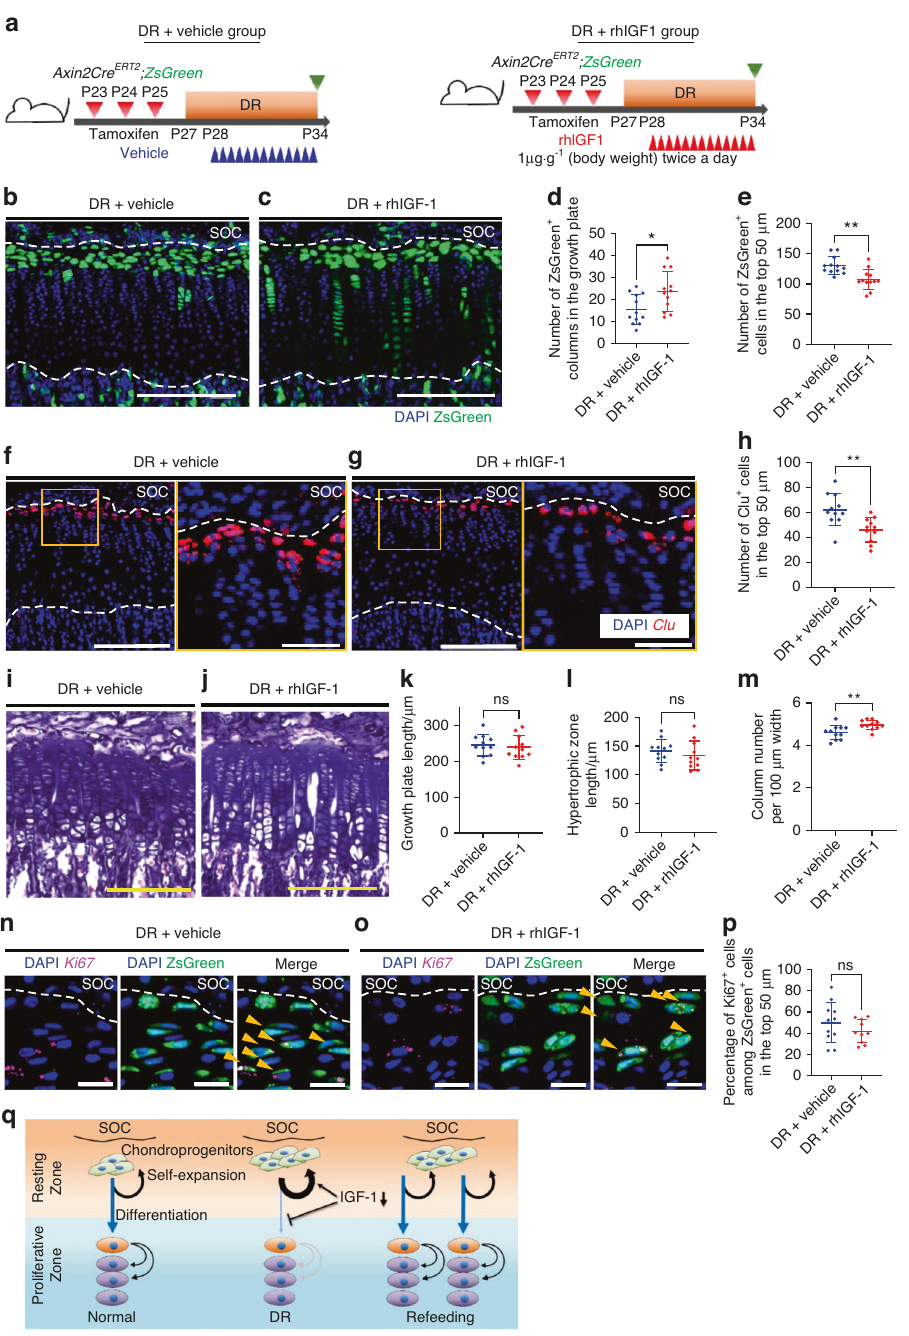
Fig. 7 Exogenous IGF-1 promotes committed differentiation of resting chondrocytes under dietary restriction. a Schematic diagrams of the fate-mapping analysis of Axin2 + cells in the proximal tibial growth plate in Axin2Cre ERT2 ;R26R ZsGreen mice (pulsed on P23 – 25 and traced for 11 days). b Representative images of descendants of initially labeled Axin2 + cells (ZsGreen + cells) in the proximal tibial growth plate in the DR + vehicle ( b ) and DR + rhIGF-1 ( c ) groups. d , e Quanti fi cation of the ZsGreen + columns in the growth plate ( d ) and ZsGreen + cells in the top 50 µm ( e ). DR + vehicle group ( n = 12), DR + rhIGF-1 group ( n = 12). f , g Representative images of in situ hybridization of Clu in the proximal tibial growth plate in the DR + vehicle ( f ) and DR + rhIGF-1 ( g ) groups. h Quanti fi cation of Clu + cells in the top 50 μ m. DR + vehicle group ( n = 11), DR + rhIGF-1 group ( n = 11). i , j Representative images of hematoxylin and eosin staining in the proximal tibial growth plate in the DR + vehicle ( i ) and DR + rhIGF-1 ( j ) groups. k – m Quanti fi cation of growth plate length ( k ), hypertrophic zone length ( l ) and column number per 100 µm width ( m ). P = 0.666 9 (ns) ( k ), P = 0.426 4 (ns) ( l ), ** P = 0.008 4 ( m ). Data are presented as the mean ± SD. n , o Representative images for in situ hybridization of Ki67 and ZsGreen + cells in the proximal tibial growth plate in the DR + vehicle group ( n ) and the DR + rhIGF-1 group ( o ). Arrowheads, ZsGreen + cells expressing Ki67 ( n , o ). p Percentage of Ki67 + cells among ZsGreen + cells in the top 50 µm. q Graphical summary of how the dynamics of chondroprogenitors change during DR and refeeding. Scale bars: 200 μ m ( b , c , f [left], g [left], i , j , 50 μ m f [right], g [right]), 20 µm ( n , o ). All data are presented as the mean ± SD. Statistical signi fi cance was determined by one-way analysis of variance and Tukey ’ s multiple comparison test ( b , f , j , r ) or by unpaired two- tailed t test ( k , n